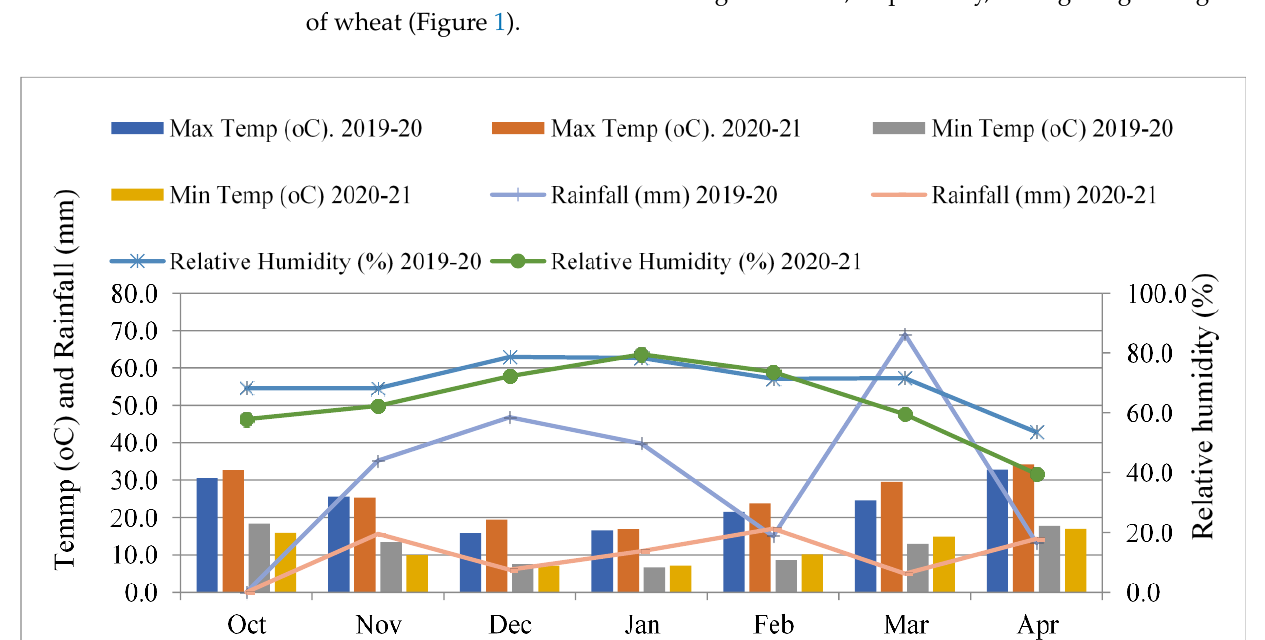
Figure 1. Monthly average maximum and minimum temperature, relative humidity and rainfall of the study area.